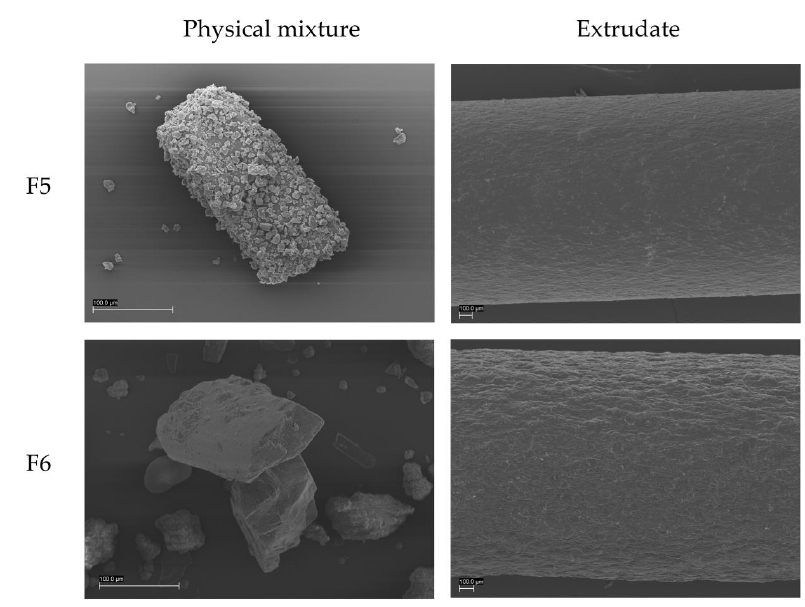
Figure 3. SEM images of the physical mixtures and extrudates of formulation 5 and 6 (Scale: 100 µm).